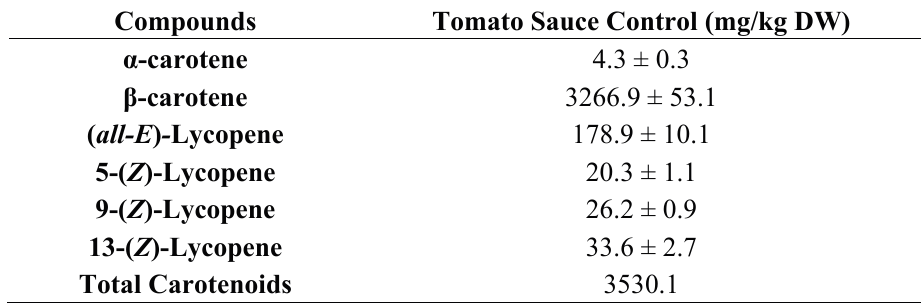
Table 1. The carotenoids profile of tomato sauce control without addition virgin olive